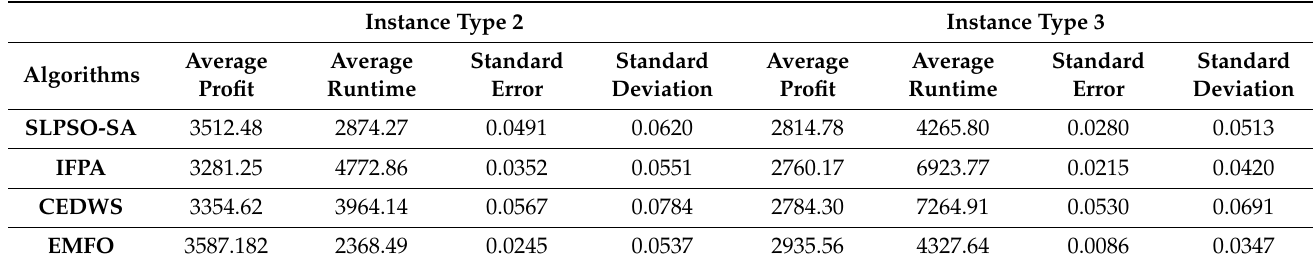
Table 8. Comparison of simulation results of instance type 2 and